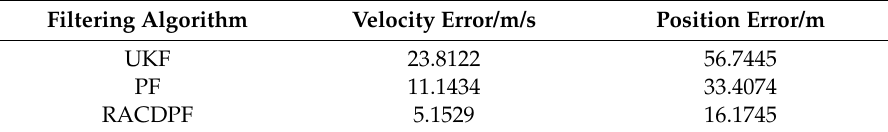
Table 4. The error statistics of the three filtering algorithms ( M =